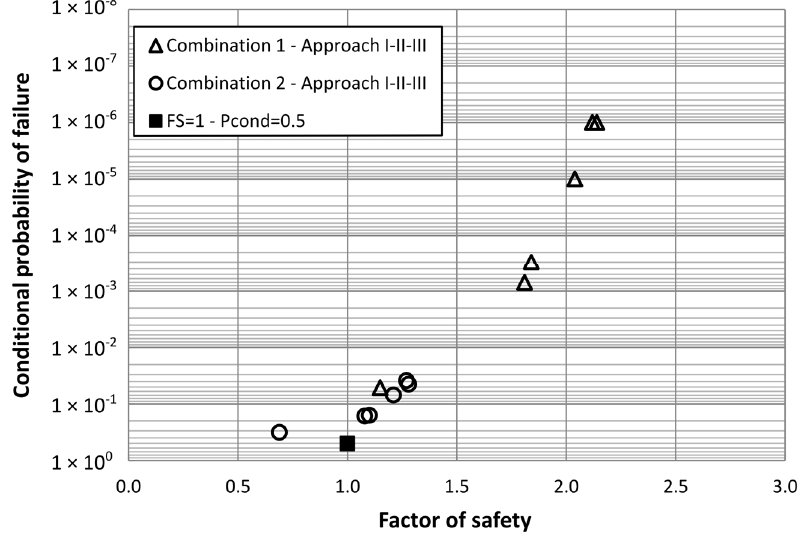
Figure 4. Factor of safety vs. conditional probability of failure using 5% fractile for strength characteristic values.